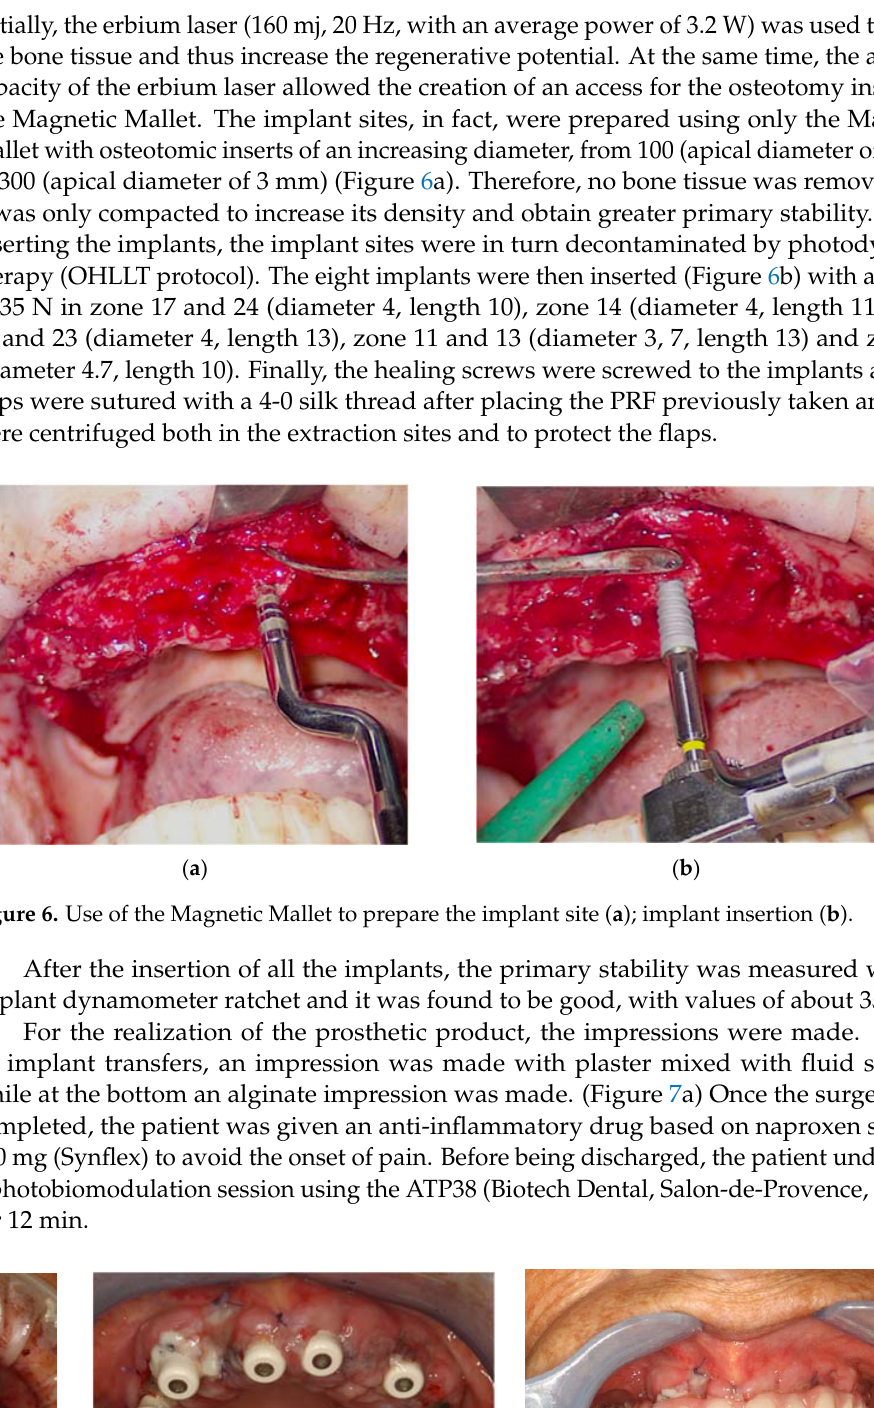
Figure 5. Oxygen high level laser therapy, OHLLT ( a ); measurement of the post ‐ extraction site ( b ).